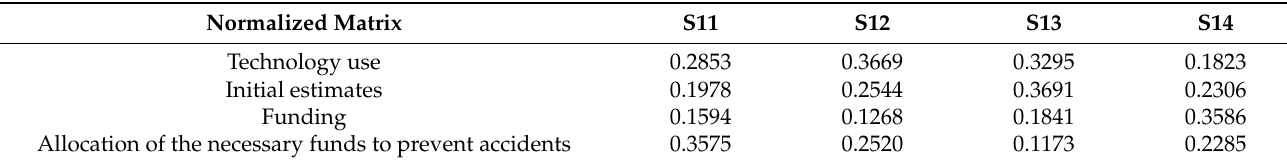
Table 12. The normalized matrix related to the resource